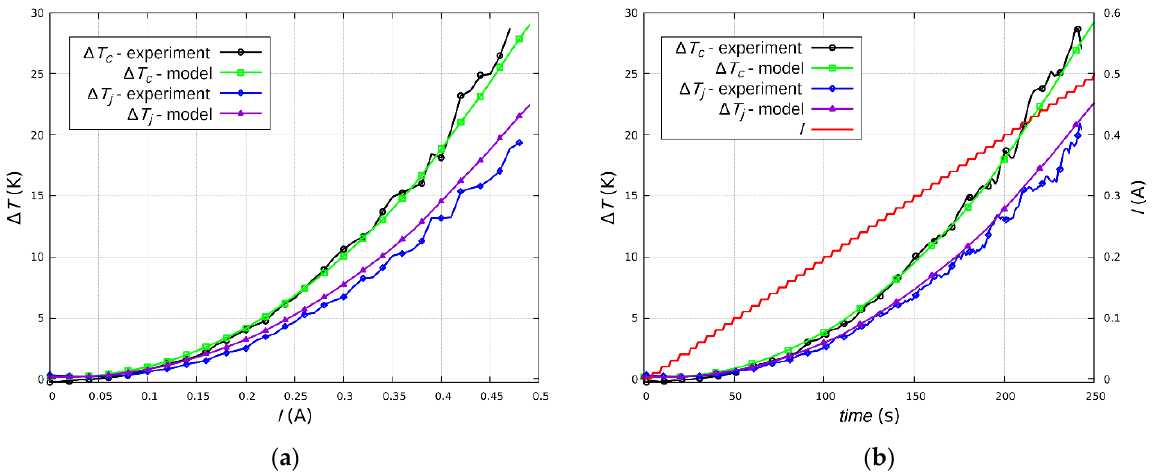
Figure 12. Experimental and simulation temperature changes at the point with the highest temperature (center of the sample T c ) and at the joint (T j ): ( a ) temperature-current relationship; ( b ) current and temperature time dependence.